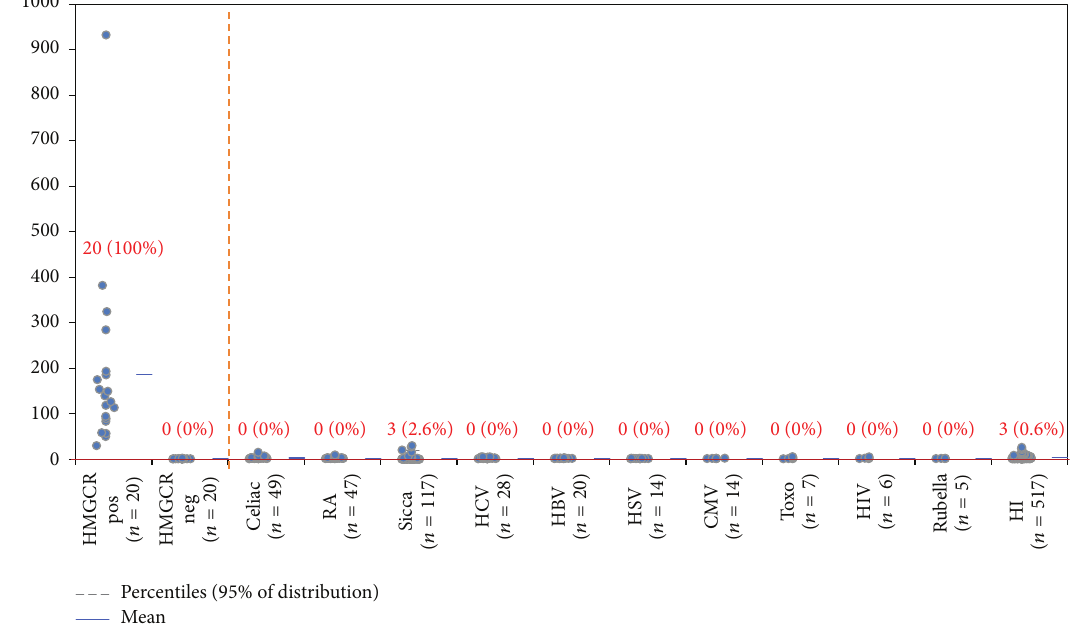
Figure 3: Comparative descriptive analysis of anti-HMGCR antibodies detected by ELISA. On the left side of the orange dotted line samples identified based on addressable laser bead assay are shown. On the right side of the dotted line, the results of various disease controls are displayed. Anti-HMGCR antibodies detected in various disease cohorts using ELISA show high disease specificity (99.3%).